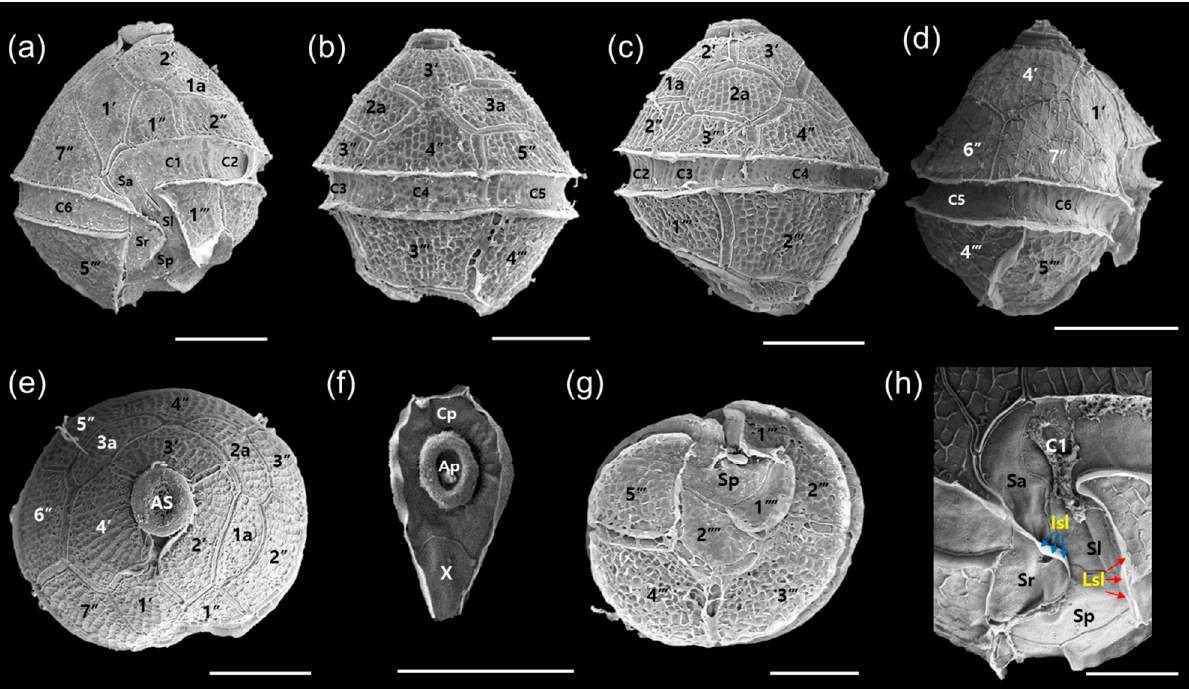
Figure 2. Scanning electron micrographs of vegetative cells of Bysmatrum subsalsum strain LIMS-2685 from Korea. ( a ) Ventral view. ( b ) Dorsal view. ( c ) Dorsal-left lateral view. ( d ) Ventral-right lateral view. ( e ) Apical view, showing a centrally located raised dome (apical stalk: AS) and epithecal plate pattern. ( f ) Detail of apical pore complex showing the apical pore (AP), cover plate (Cp) and canal plate (X). ( g ) Antapical view, showing hypothecal plate pattern. ( h ) Detail of the sulcal plates showing anterior sulcal plate (Sa), right sulcal (Sr) and left sulcal (Sl) plates, posterior sulcal plate (Sp), left (Lsl; red arrows) and internal (Isl; blue arrows) sulcal lists. Scale bars = 10 µm ( a – e , g ); 5 µm( f , h ).